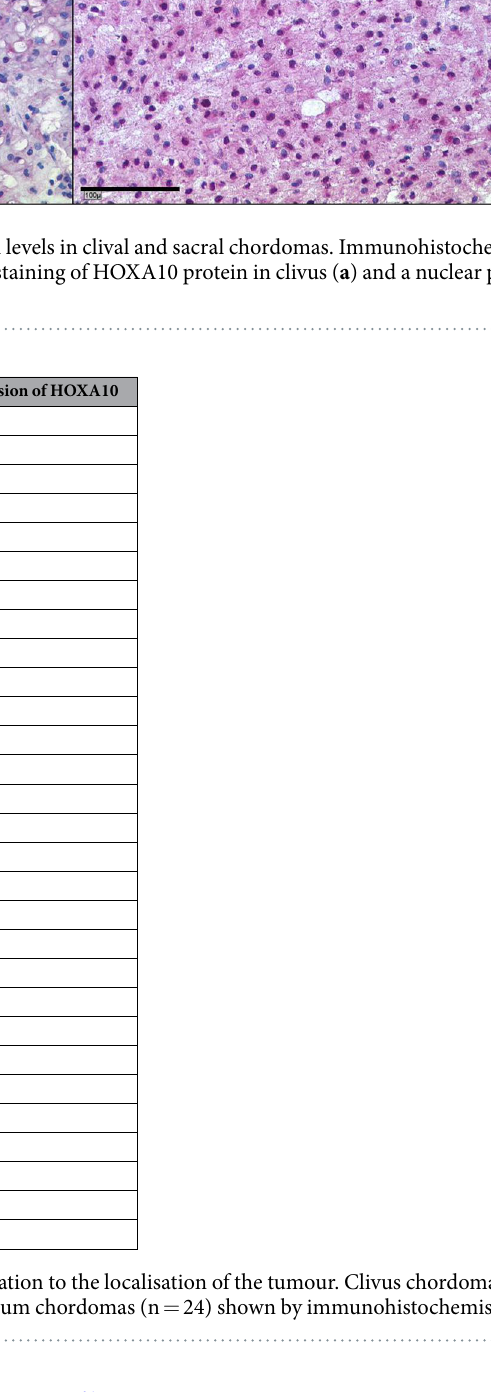
the development of the anterior posterior body axis 24 . The downregulation of HOX genes was validated in qPCR and confirmed in our tissue cohort. Whether the differential HOX gene expression between clival and sacral chordoma is solely oncofetal in ori- gin or has a pathologic role in the phenotype of the more aggressive sacral chordomas is an open question. Considering the redundancy within paralogue groups and the temporal and spatial collinearity, HOX expression effects solely caused by the localisation of the tumour would result in most of the 3 ′ - HOX genes being up and 5 ′ - HOX genes (including further members of the paralogue groups) being downregulated in clival chordoma